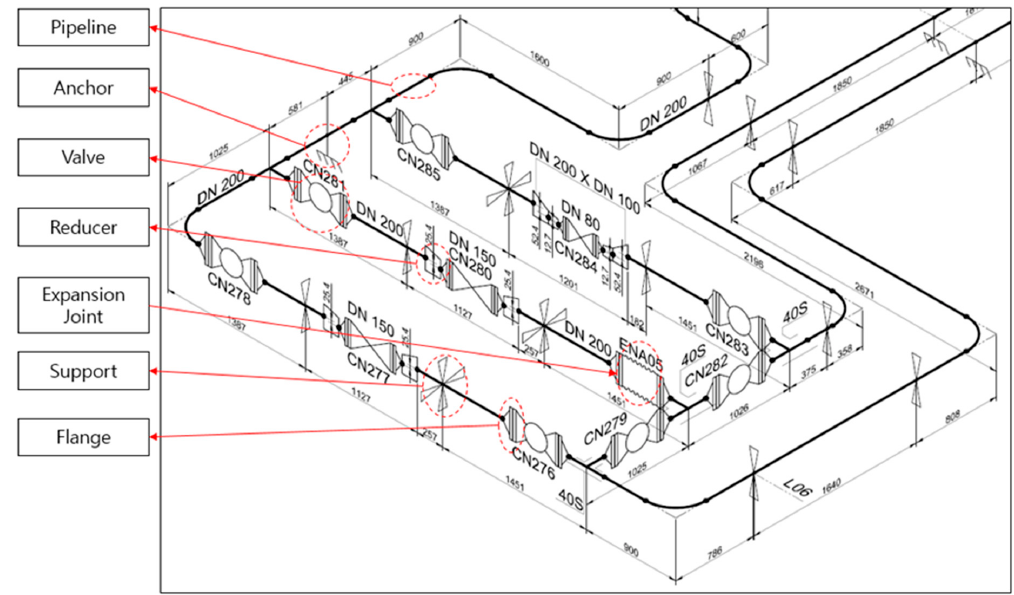
Figure 3. International Organization for Standardization (ISO) drawing of main liquid pipeline.